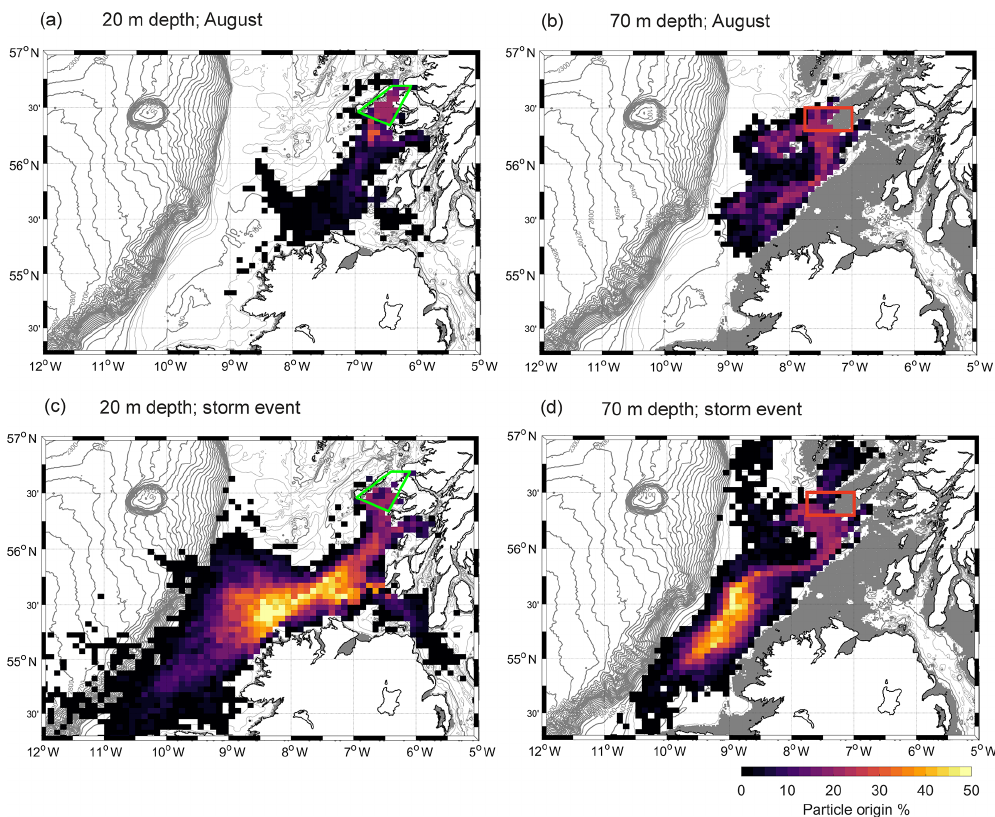
Figure 6. Particle distribution maps showing the origin of particles advected through Tiree Passage and the inner Malin Shelf. The green polygon shows the observation region for the 20m particles in (a, c) ; for the 70m particles in (b, d) the polygon (red) instead bisects the tracks of the drogued drifters as Tiree Passage is not open at this depth. Each cell is coloured by the percentage of particles released at that location which were subsequently advected through the observation region. The observation period for (a, b) is 1 to 11 August 2013, and for (c, d) it is 15 to 25 December 2013. Note that these maps show particle release locations only and are not representative of model resolution. Bathymetry contours from EMODnet bathymetry (https://www.emodnet-bathymetry.eu/, last access: September